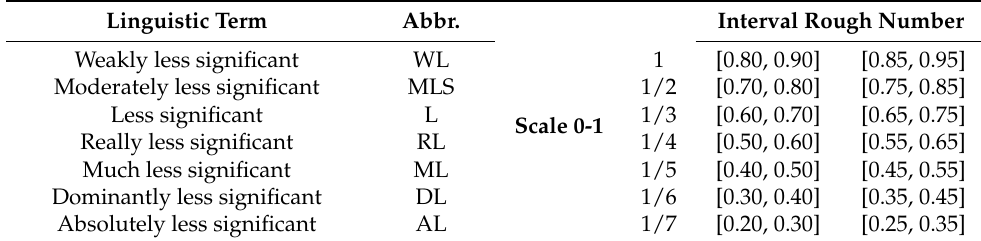
Table 2. Criterion evaluation by linguistic scale